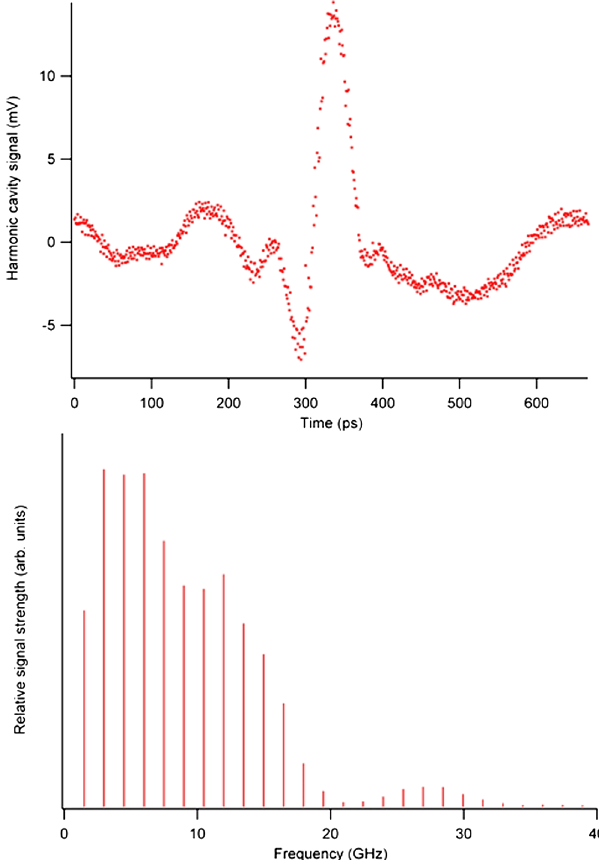
FIG. 9. Top: Raw oscilloscope waveform showing a band- width-limited electron bunch-length measurement for 25 μ A average current at 499 MHz repetition rate and 500 keV beam energy. Bottom: the spectral content of the same waveform indicating the harmonically resonant cavity ’ s operational band- width of ∼ 20 GHz.